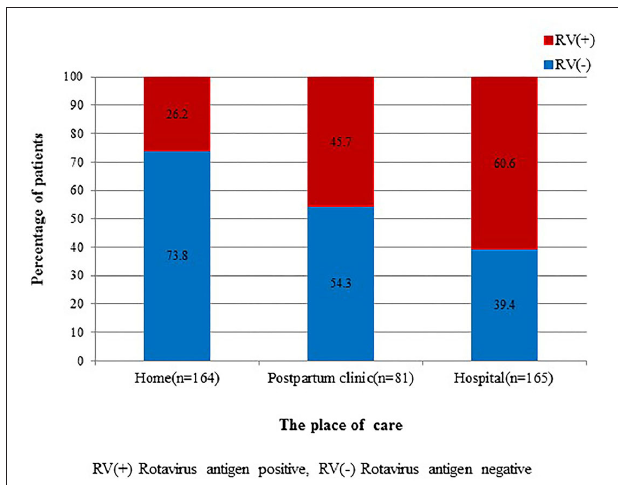
FIGURE 4 | Comparison of rotavirus infection among admitted cases from home, postpartum clinic, and hospital. There are statistically significant differences among the three groups ( P = 0.000).